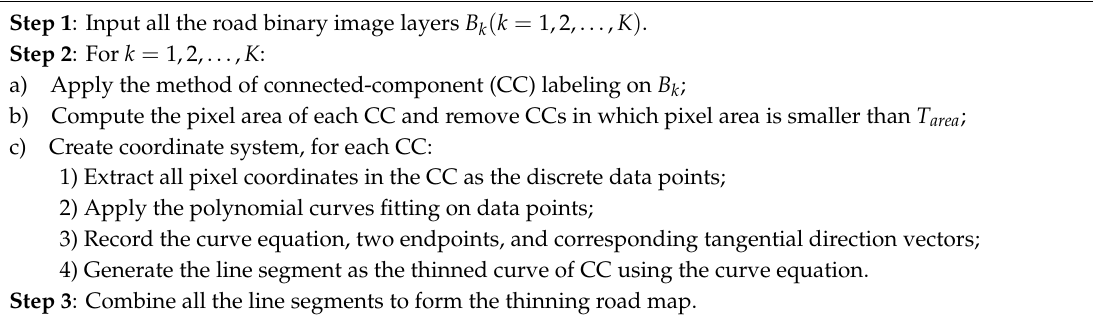
Algorithm 1 . Thinning based on polynomial curve fitting